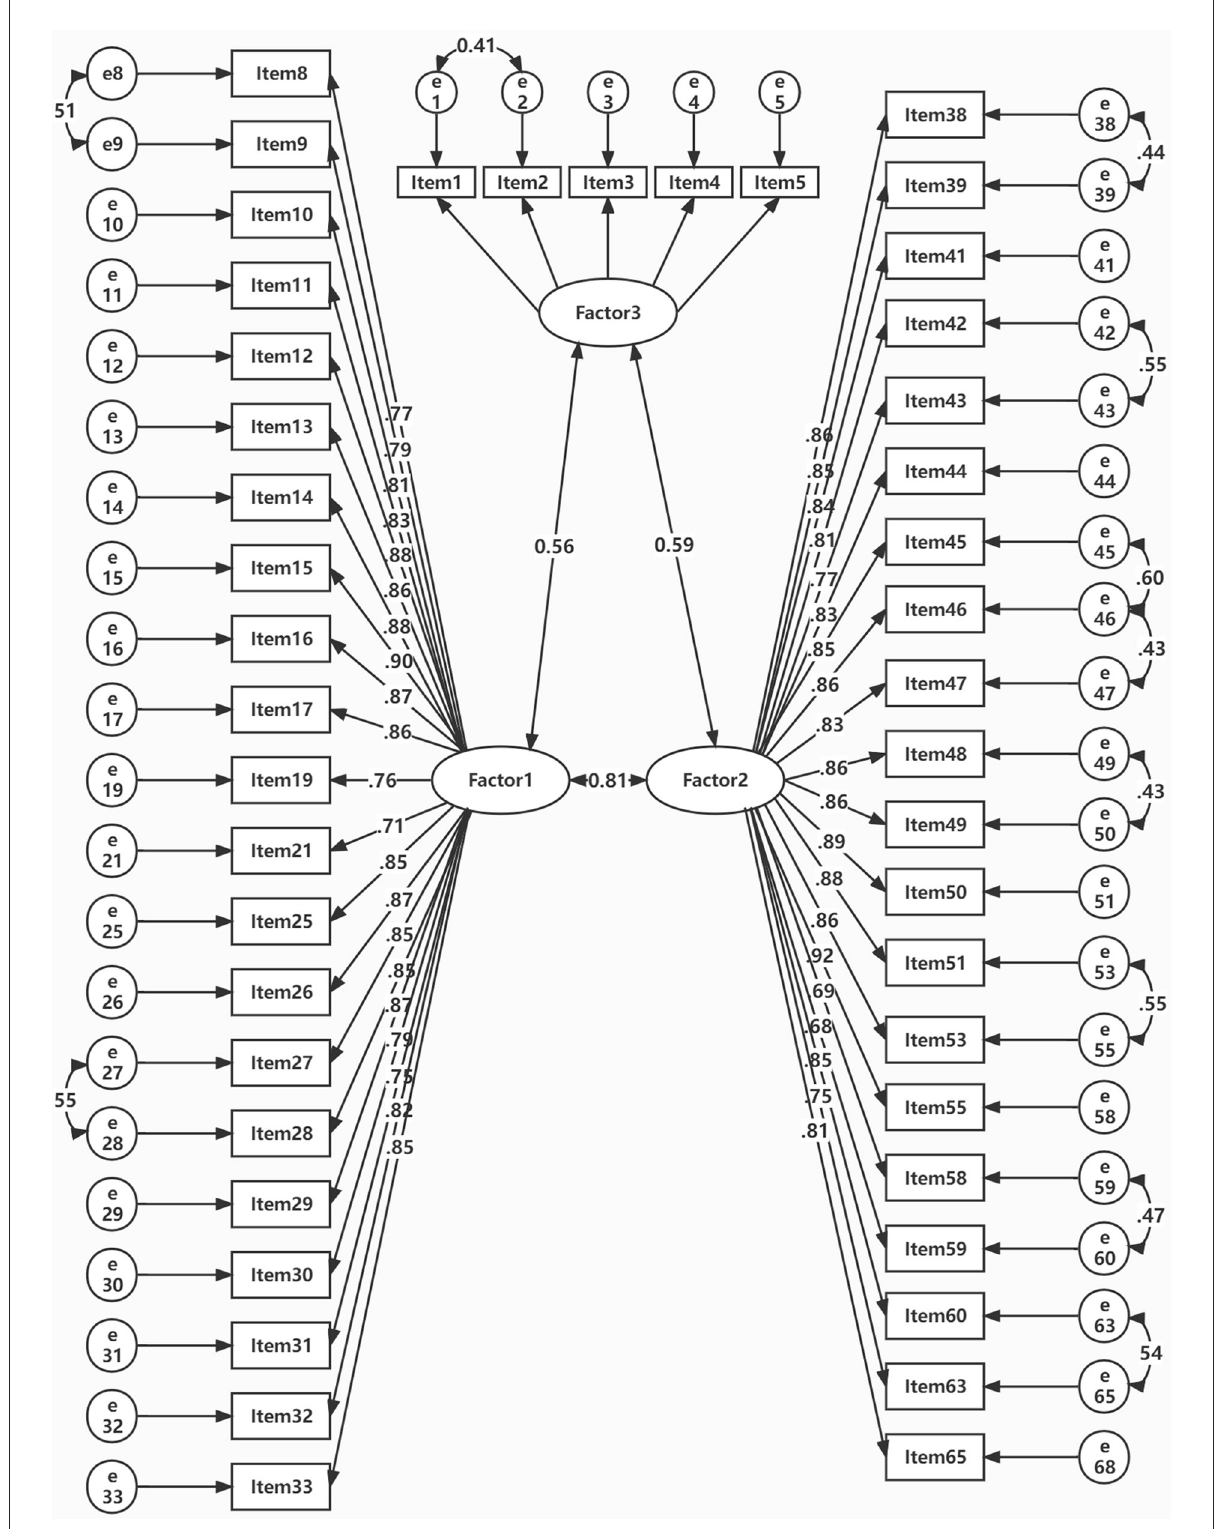
FIGURE1 Standardized parameter estimates for the second-order